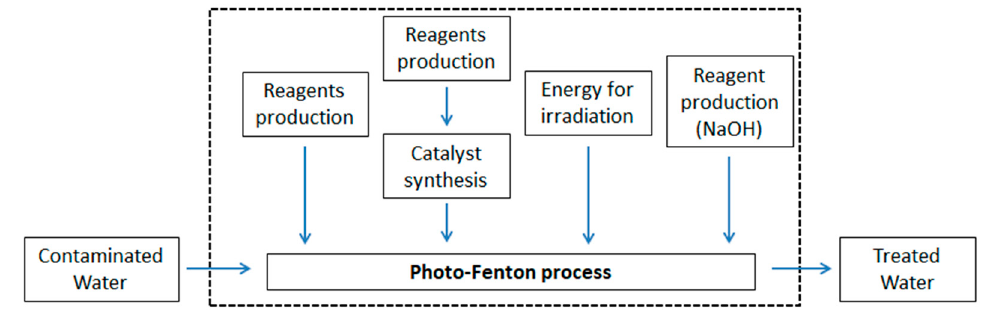
Figure 3. System boundary for the heterogeneous photo-Fenton processes. Only the unit processes contained in the dashed box were considered during the life cycle assessment (LCA) analysis.